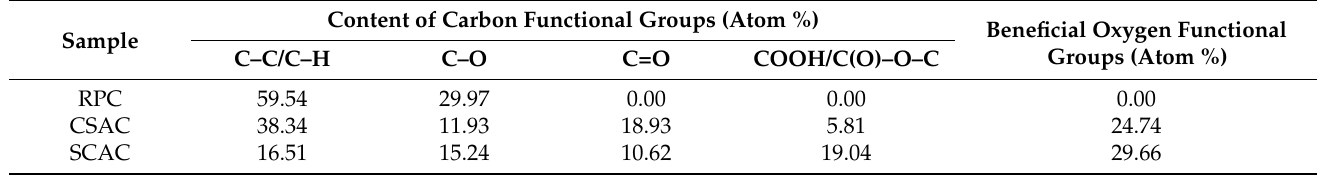
Surface functional groups obtained by deconvolution of the C 1s XPS Peak [31]. Reprinted/adapted with permission from Ref. [31]. 2020, Energy and Fuels.